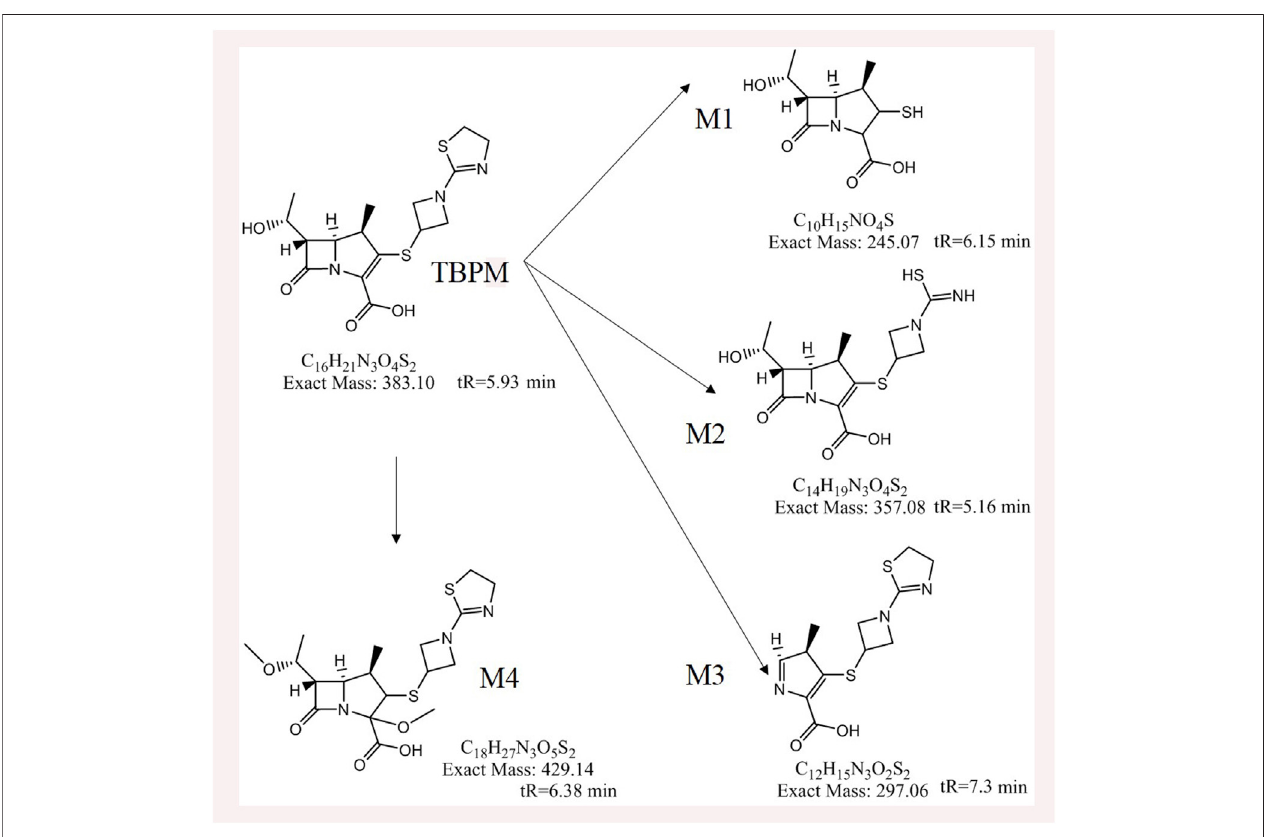
FIGURE 6 | Proposed metabolic pathways of TBPM to M1 –